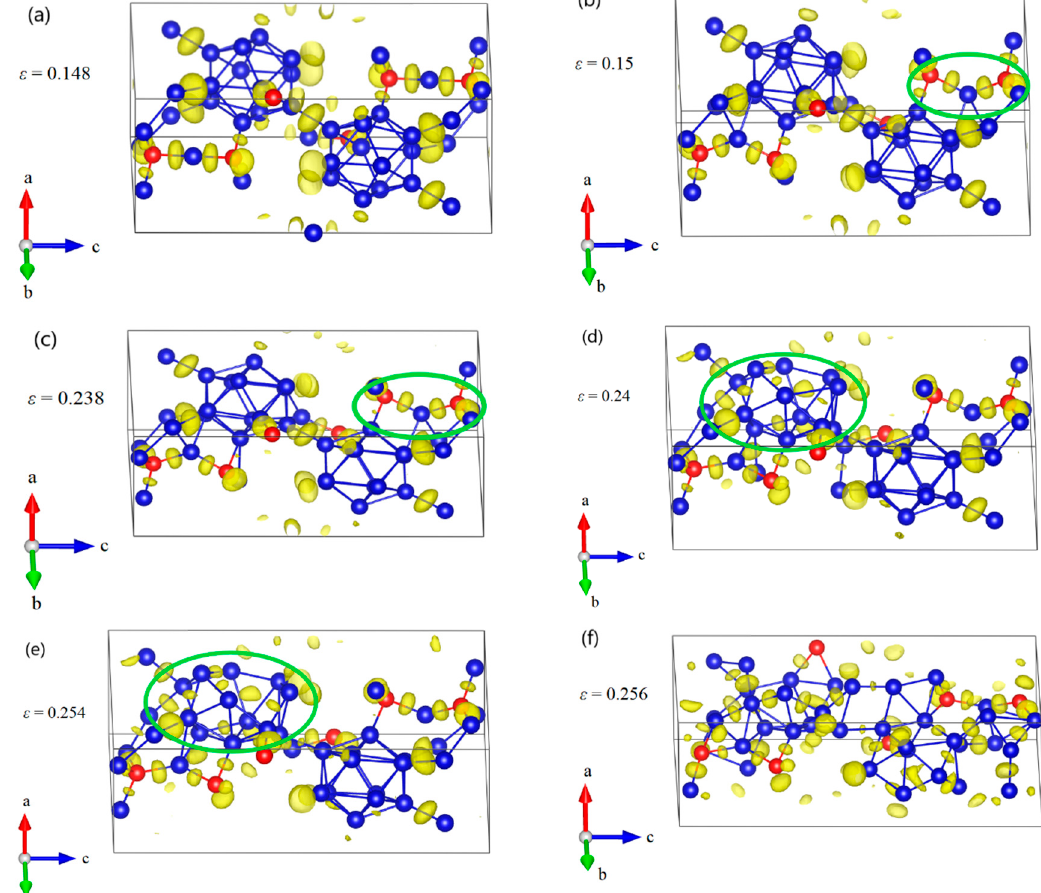
Figure 7. The structural changes and ELF at various critical strains for B 12 –CBC structure under a axis uniaxial compression: ( a ) the structure at ε = 0.148 where it uniformly resists the elastic deformation and the C–B–C chains are almost straight; ( b ) the structure at ε = 0.15 where some new B–B bonds are formed, leading to a small stress fluctuation; ( c ) the structure at ε = 0.238 before the first significant stress drop where the icosahedra are identifiable and intact; ( d ) the structure at ε = 0.24 after the first stress drop, where one of the icosahedra are broken. ( e ) the structure at ε = 0.254 before structural failure; ( f ) the structure at ε = 0.256 where the icosahedra and the structure are fully destroyed (Blue = B atoms; red = C atoms).